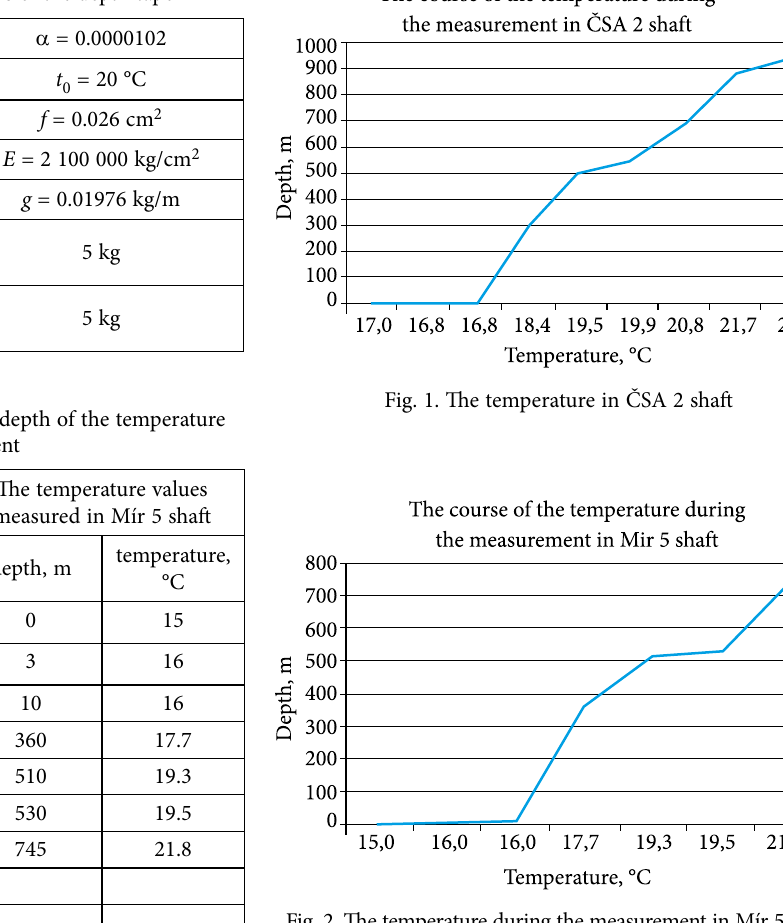
Table 1. Technical parameters of the depth tape